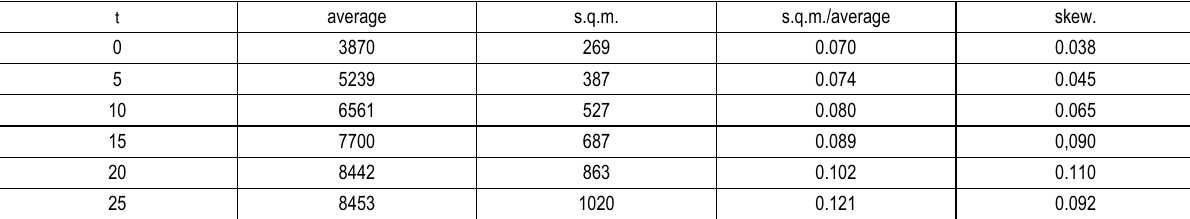
(cid:5) U evidenced for the standard stochasticity level, excluding contract escapes t